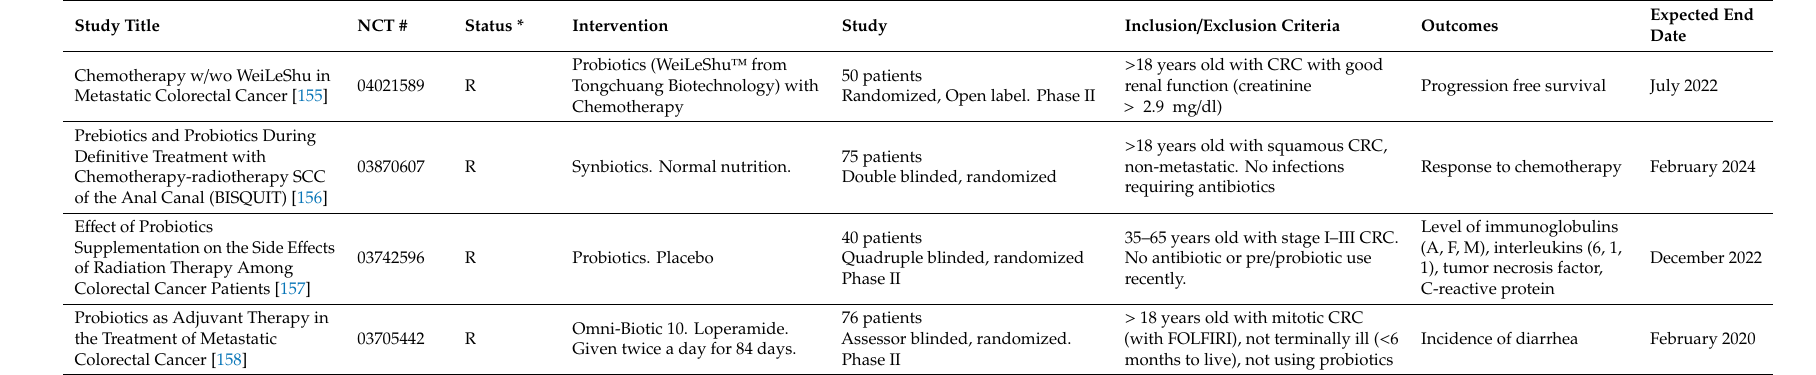
Table 5. Ongoing / recruiting clinical trials for